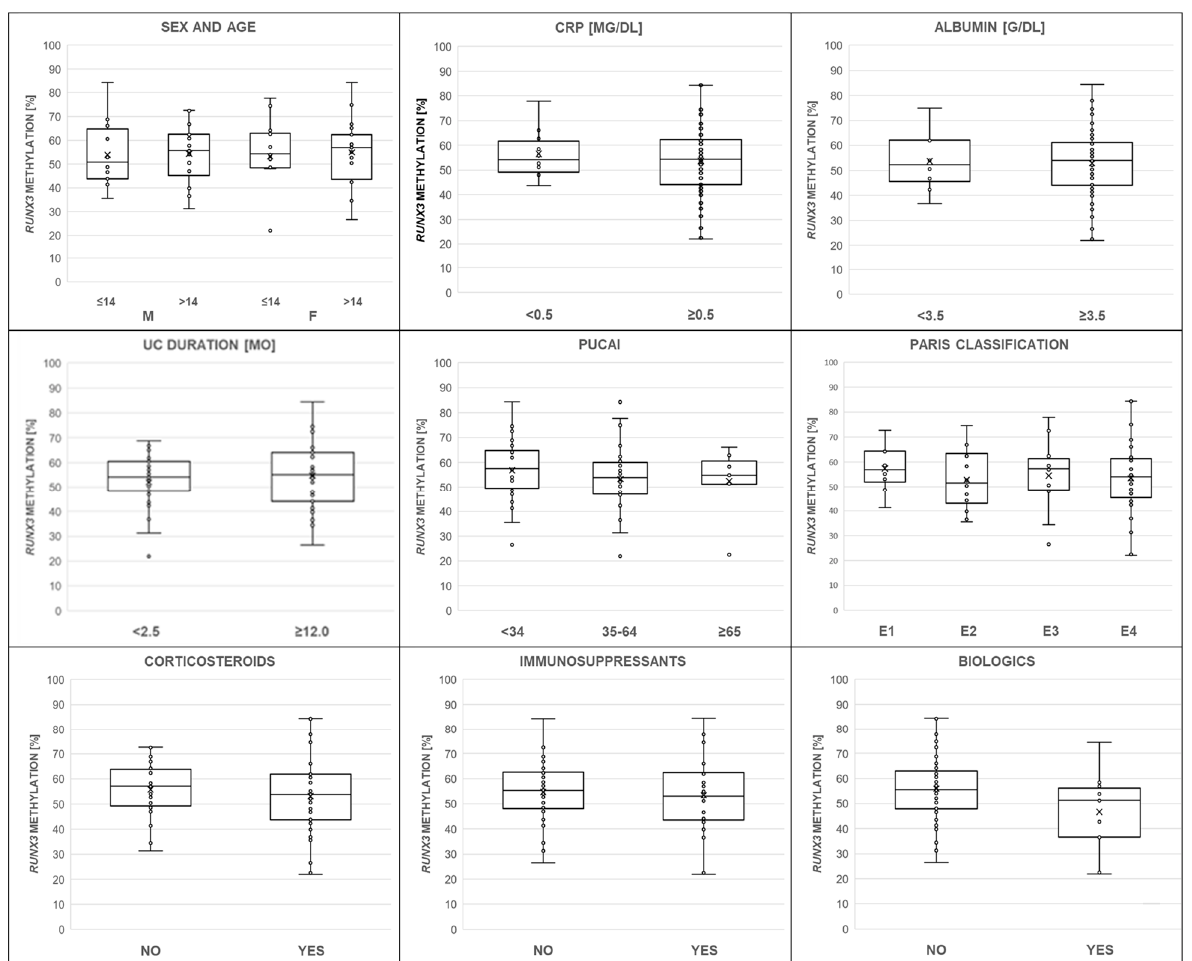
Figure 2. The relationship of the RUNX3 methylation level (%) to clinical characteristics such as patients sex and age, C-reactive protein (CRP), serum albumin, disease duration, Pediatric Ulcerative Colitis Activity Index (PUCAI), colitis extent according to the Paris classification (E1–E4), and exposure to medications (corticosteroids, immunosuppressants, and biologics, respectively). The mean is indicated with an “x” mark. Additionally, the median is shown as a horizontal line within box plots. None of the obtained associations were considered significant ( p > 0.05).